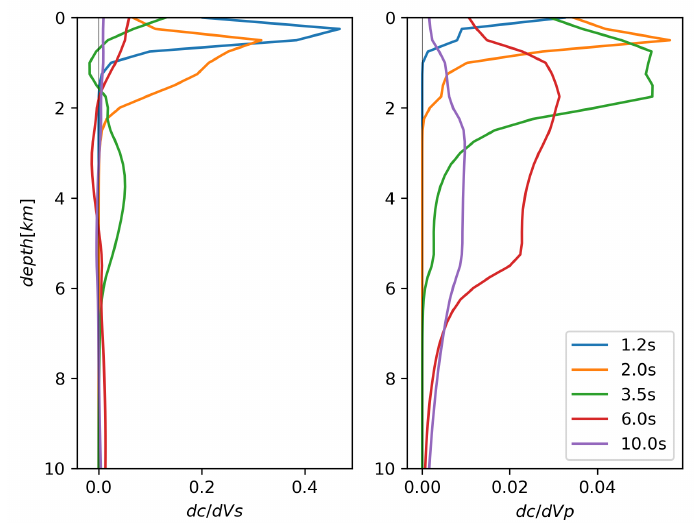
Figure 10. Sensitivity kernels relating Rayleigh-wave phase velocity estimates to Vs ( left ) and Vp ( right ) at depth. Note the difference in horizontal scale between the left and right panels: sensitivity of Rayleigh waves to Vp is one-order-of-magnitude smaller than their sensitivity to Vs, as expected. The reference assumed for the computation of the kernels is our final Vp, Vs profile (solid black lines in Figure 9A,B). Kernels were calculated via Keurfon Luu’s “disba” Python